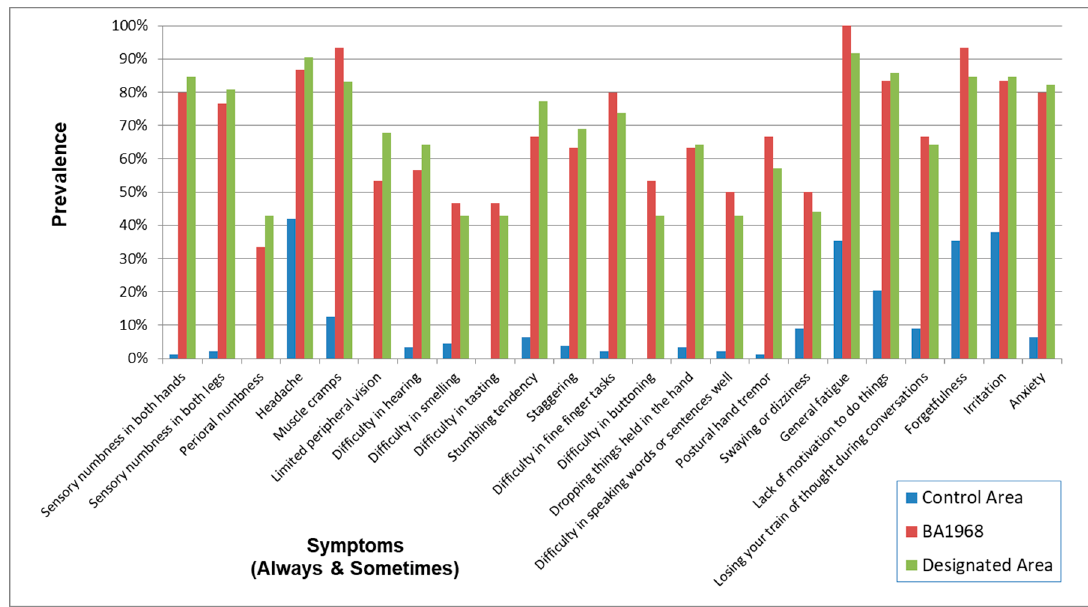
Figure 12. Prevalence of symptoms (Always and Sometimes) in the younger generation. Prevalence in BA1968 and the Designated Area were higher than in the Control Area. The symptomatic patterns in BA1968 and the Designated Area were similar.